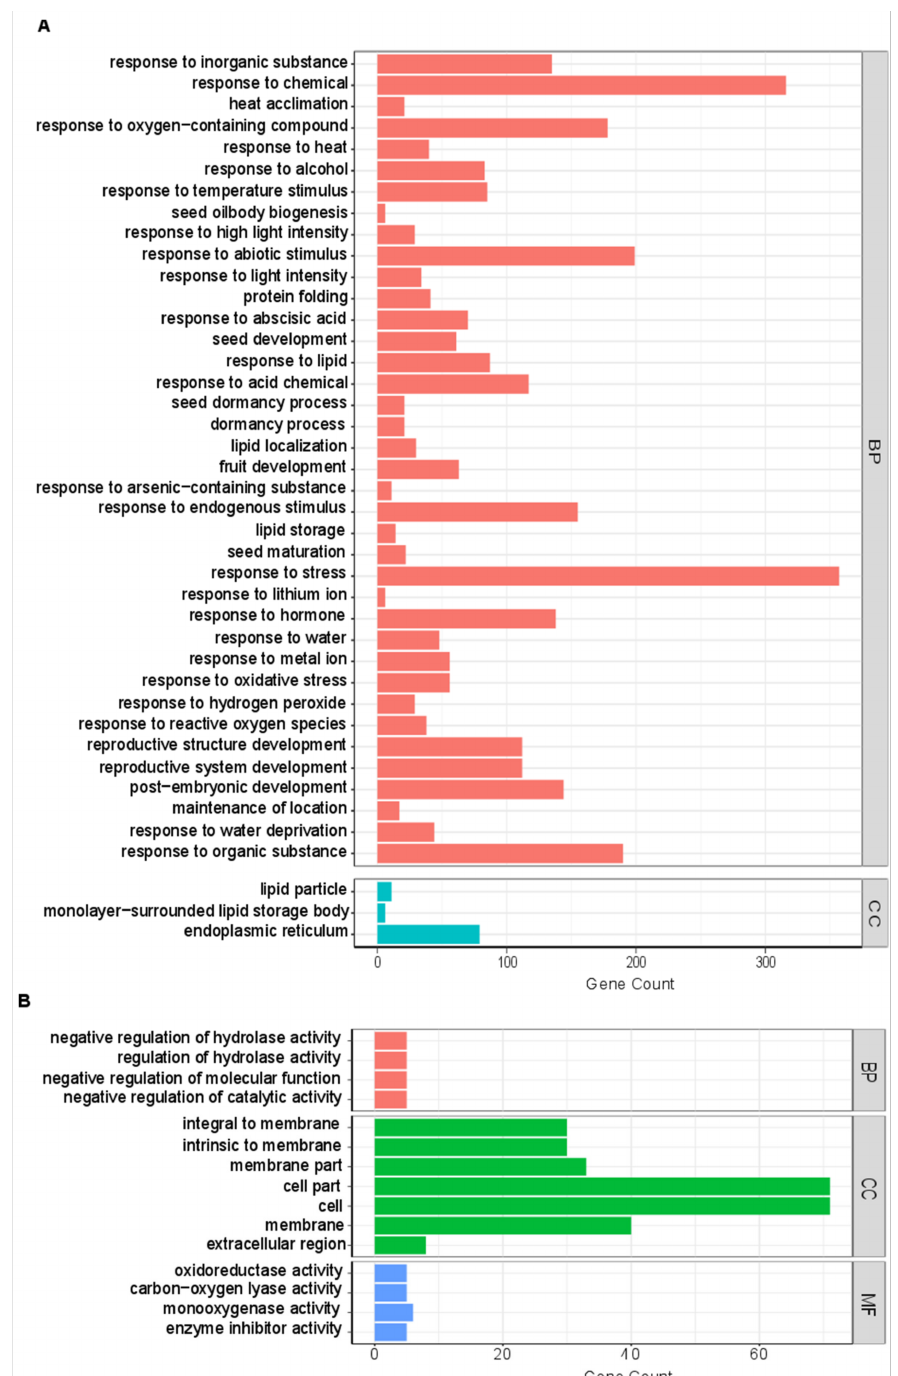
Figure 6. GO term enrichment of genes in the greenyellow ( A ) and ivory ( B